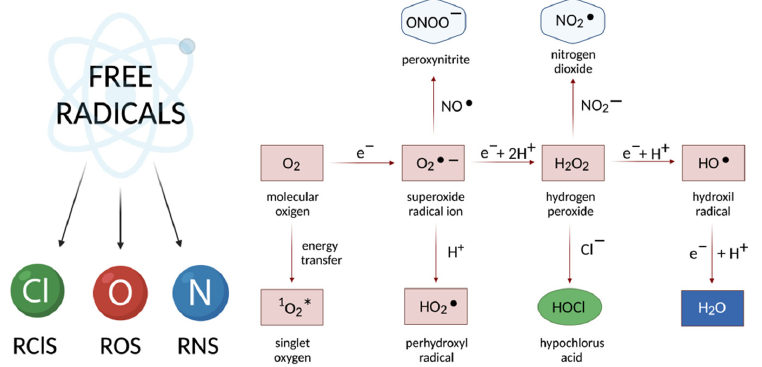
Figure 1. Scheme of free radical formation. The fundamental reaction for the formation of highly reactive free radicals is the conversion of molecular oxygen into water due to electron transfer. At different stages of this chain, the following can be formed: Reactive oxygen species (ROS), nitrogen (RNS), and chlorine (RClS).